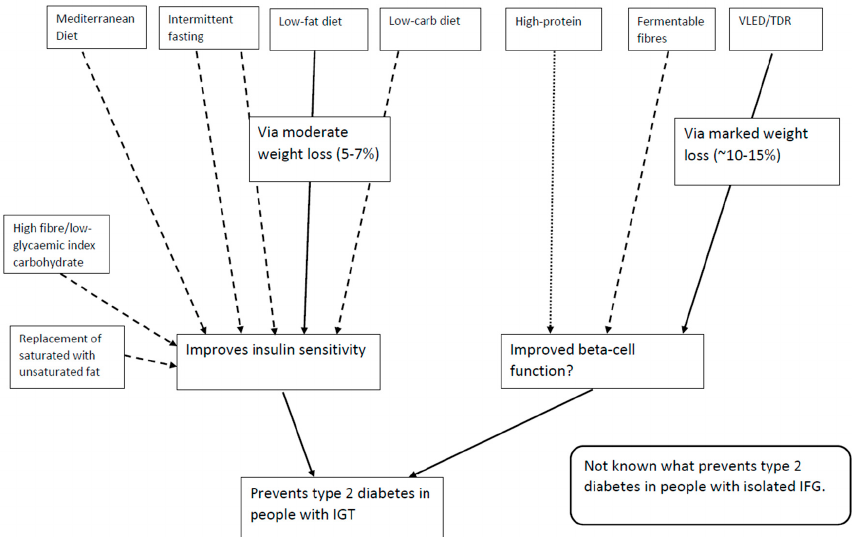
Figure 1. Current dietary strategies shown to improve (full line) or some evidence of improvement (dashed line) and potential for improvement (dotted line) for the two primary pathophysiological defects in the development of type 2 diabetes. IFG: impaired fasting glucose; IGT: impaired glucose tolerance; TDR: total diet replacement; VLED: very low energy diet (<800